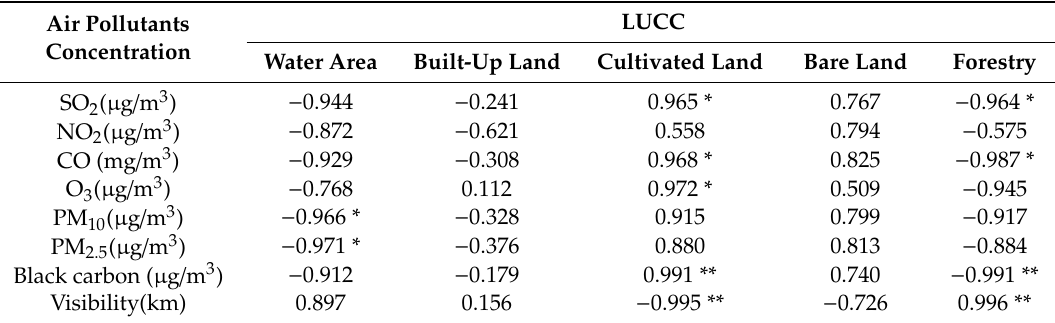
Table 4. Correlation between air pollutant concentrations and